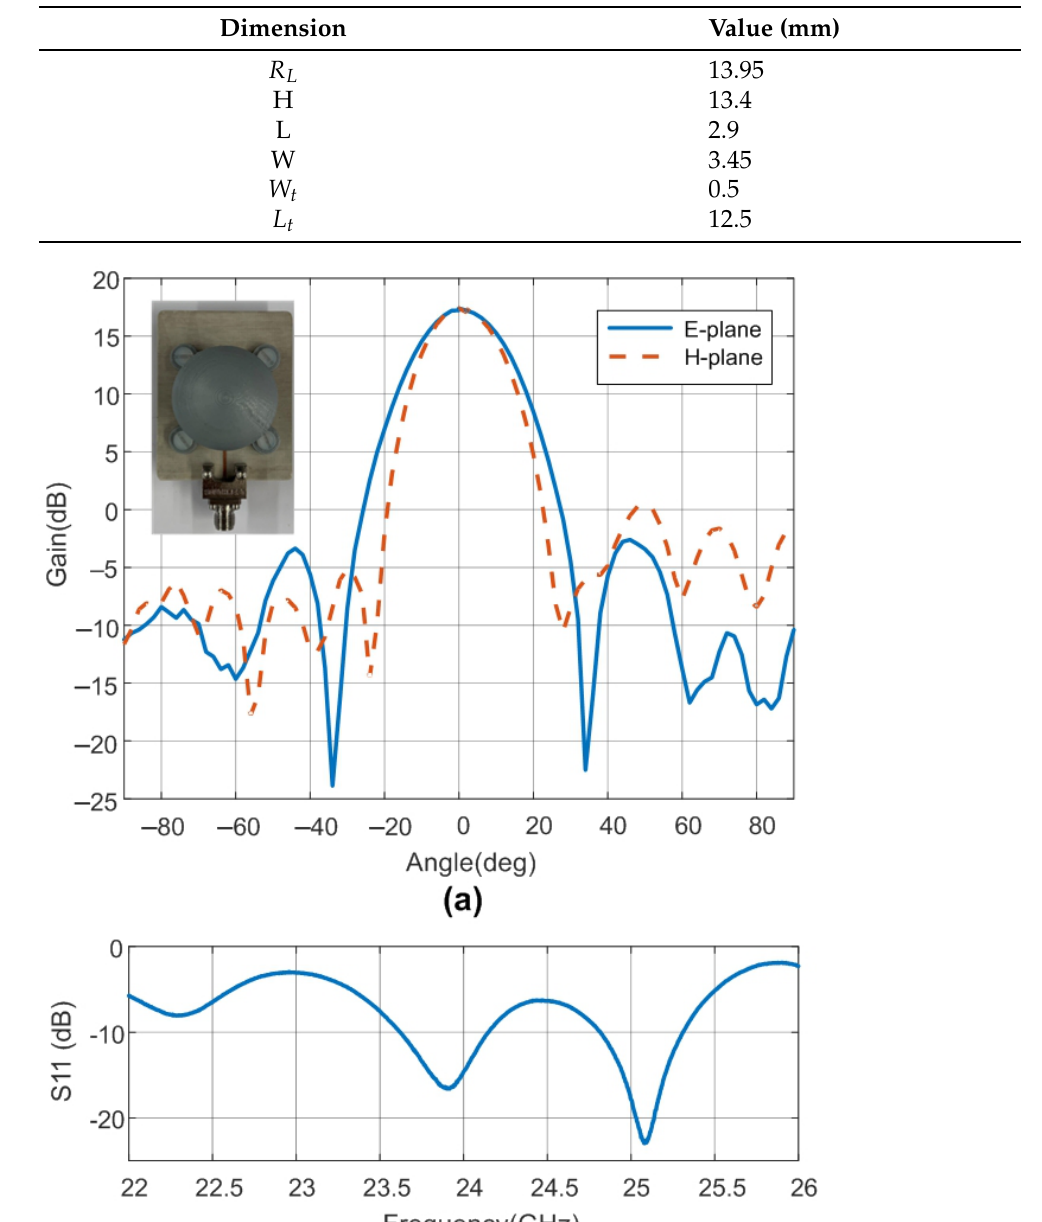
Table 1. Dimensions of the antenna.